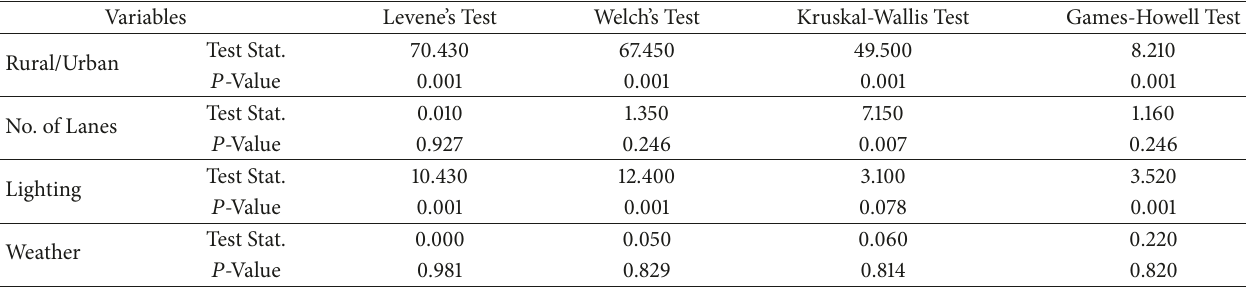
Table 7: Test for equality of mean, homogeneity of variances, and similarity in distribution of the dry pavement crashes across the categorical variables.